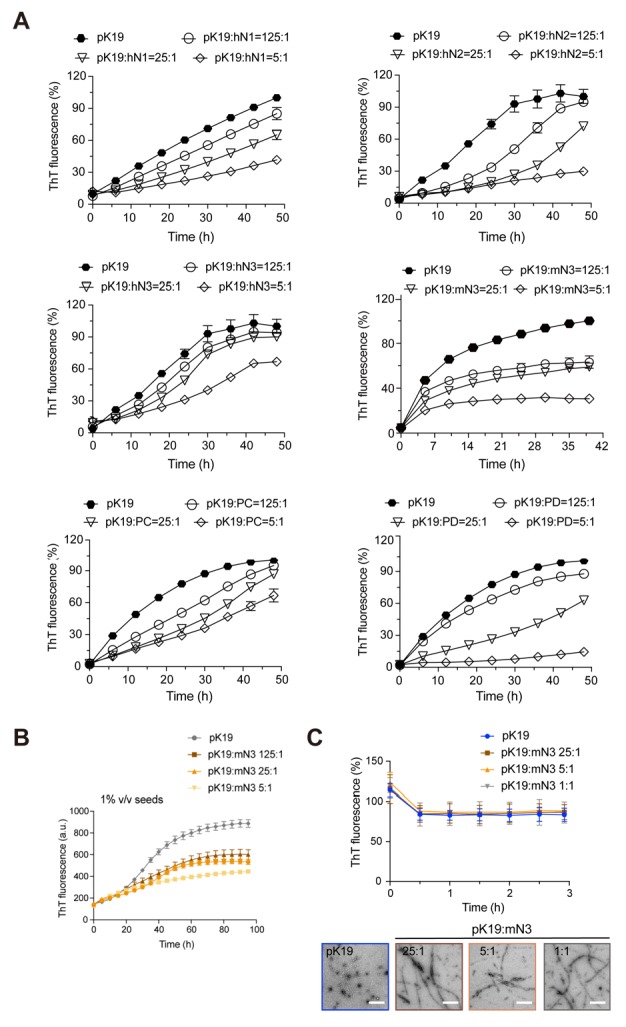
Inhibition of NMNATs on the fibril formation of pK19.(A) Inhibition of NMNATs on the amyloid fibril formation of pK19 (100 μM) measured by the ThT fluorescence kinetic assay. A gradient concentration of NMNATs was applied as indicated. The data shown correspond to mean ± s.d., with n = 3. (B) ThT fluorescent assay showed the inhibition of mN3 on the fibril formation of pK19 (100 μM) in the presence of 1% (v/v) preformed pK19 fibril seeds. Molar ratios of pK19 to mN3 are indicated. The data shown correspond to mean ± s.d., with n = 5. (C) mN3 exhibits no disaggregation of preformed pK19 fibrils measured by ThT fluorescence assay (upper). The molar ratios of pK19 to mN3 are indicated. Error bars correspond to mean ± s.d., with n = 3. TEM images (lower) show no effect of mN3 on preformed pK19 fibrils. pK19 samples were imaged by TEM after incubation with indicated concentrations of mN3 at 37°C for 3 hr. Scale bars: 500 nm.